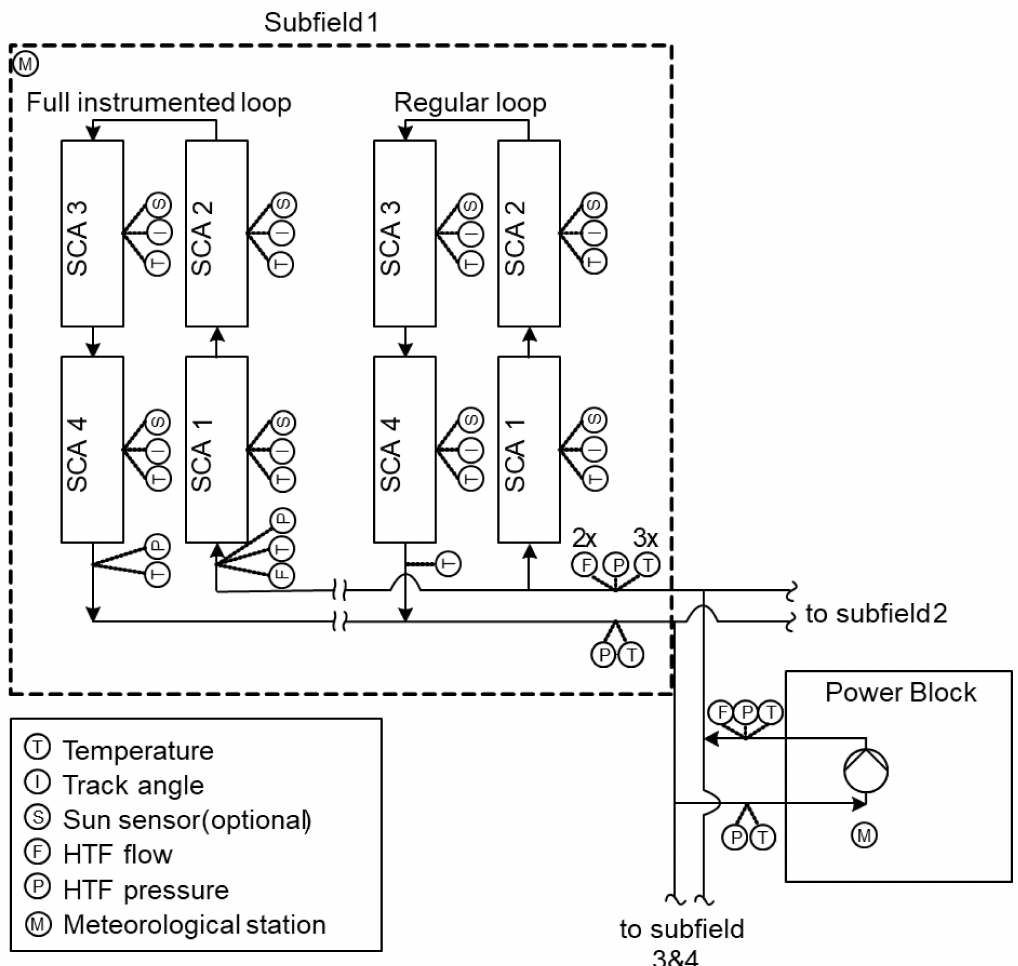
Figure 6. Spatial distribution of stationary measurement devices in the solar